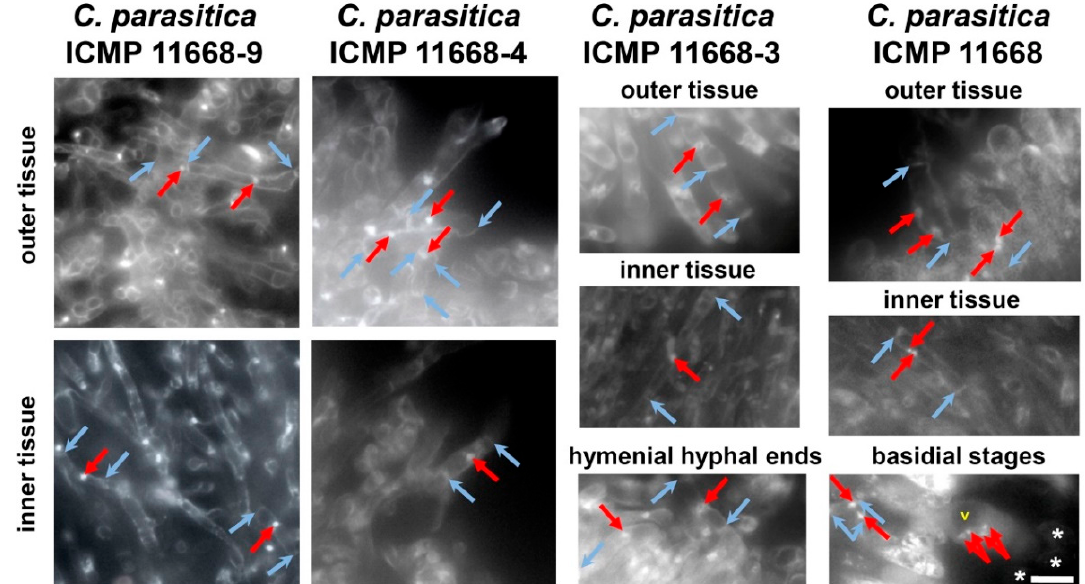
Figure 4. Nuclear state and septa allocation in fully grown dikaryotic and monokaryotic fruiting structures by C. parasitica ICMP 11668 progeny monokaryons. Cultures of C. parasitica ICMP 11668, 11668-3, -4, and -9 were grown at 25 ◦ C in the dark for 13 or 16–19 days. Fruiting induction (f.i.) took place with fully colonized plates at 20 ◦ C in a 12 h daylight/12 h dark setup at saturated humidity in microfilter-aerated wet chambers. Fully developed fruiting bodies with a distinct cap and stipe were harvested 21 days ( C. parasitica ICMP 11668 and 11668-3), 27 days ( C. parasitica ICMP 11668-9), and 57 days ( C. parasitica ICMP 11668-4) after f.i. Photographs were taken from DAPI/Calcofluor-stained microtome sections of fully developed fruiting structures. Red arrows point to nuclei, barbed blue arrows indicate two septa delimiting a hyphal segment, white asterisks indicate basidiospores, a yellow ‘v’ marks a basidial vacuole. In the dikaryon C. parasitica ICMP 11668, outer tissue corresponds to the palisade-like layer of hyphal ends at the cap surface and inner tissue corresponds to cap tissue, both displaying dikaryotic hyphal segments without clamps. The picture depicting basidial stages of C. parasitica ICMP 11668 shows an already developed basidium in the hymenium that is connected to the hypha from which it arose by a simple septum (no clamp connection at the septum). In the fruiter type monokaryon C. parasitica ICMP 11668-3, outer tissue corresponds to hyphal ends at the lower cap margin surface while inner tissue corresponds to stipe tissue close to